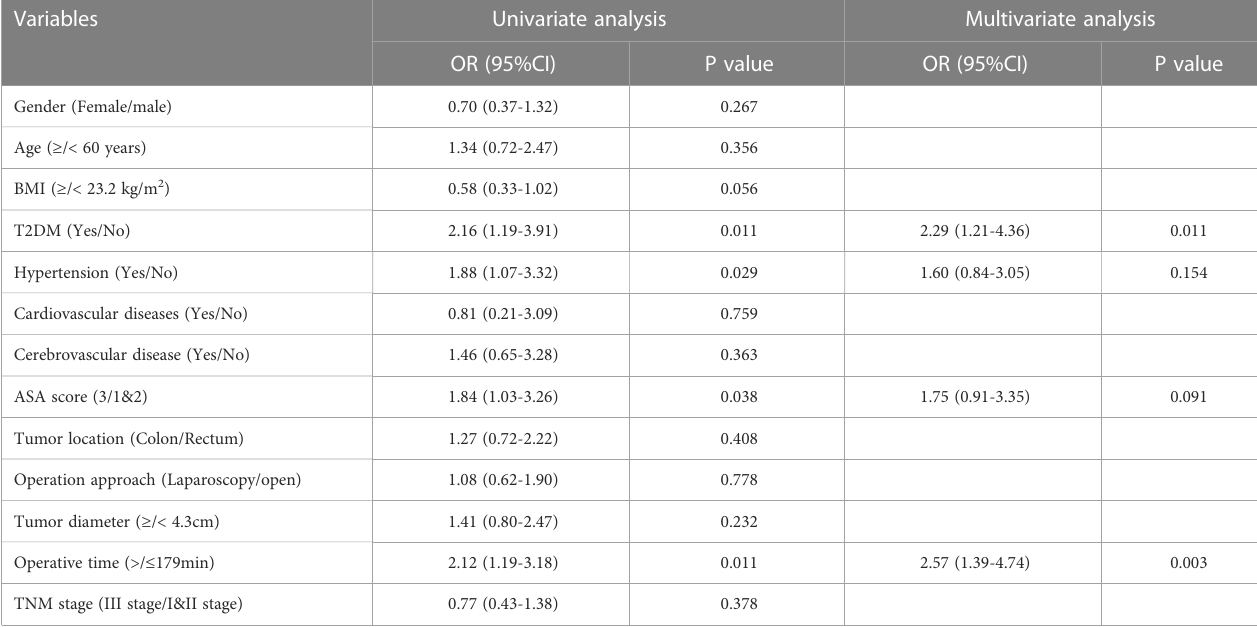
TABLE 3 Univariate and multivariate analyses of overall complications.